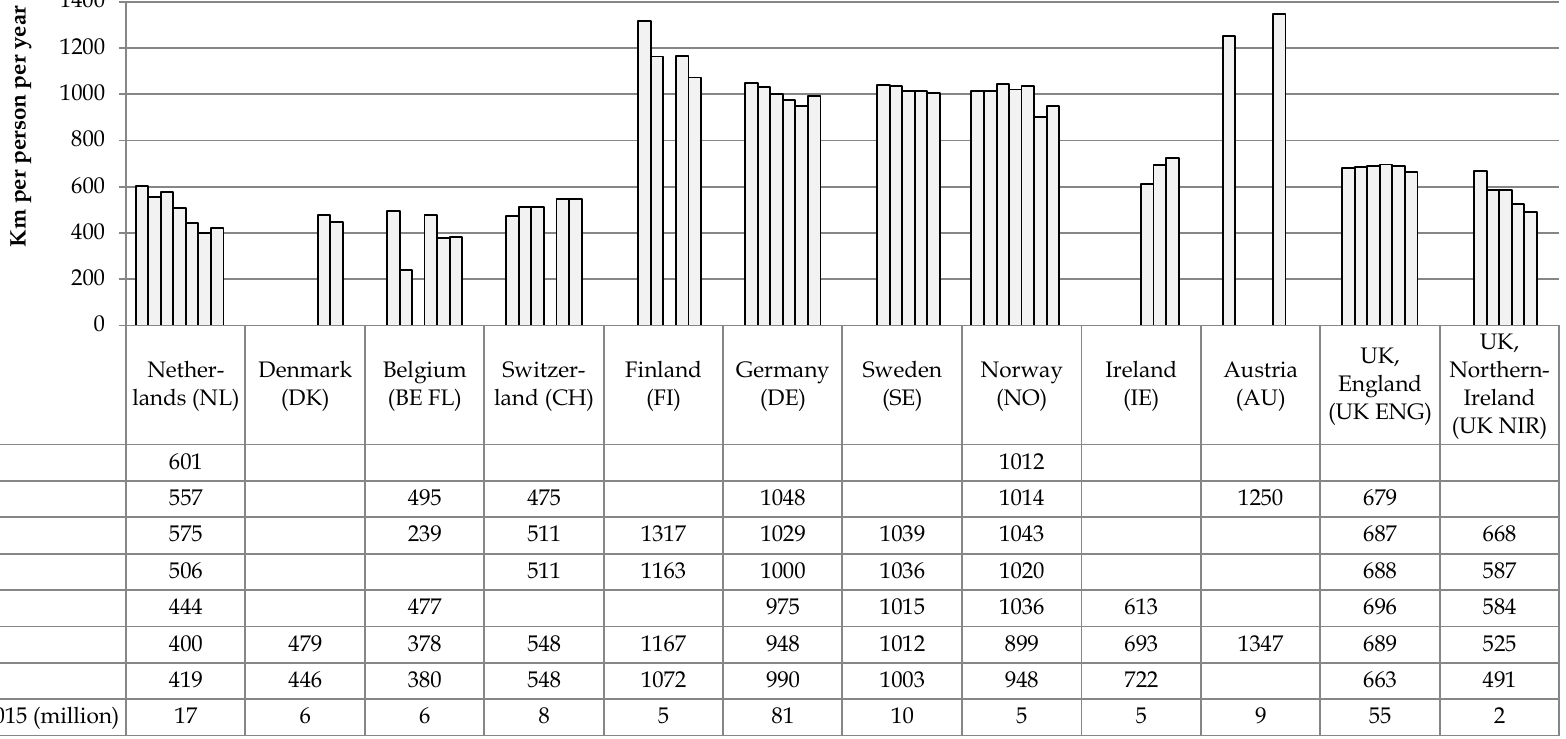
Figure 9. Distance travelled by bus, tram or metro (bus only in Denmark, Ireland, and Sweden) per capita per year between 1990 and 2017, and population